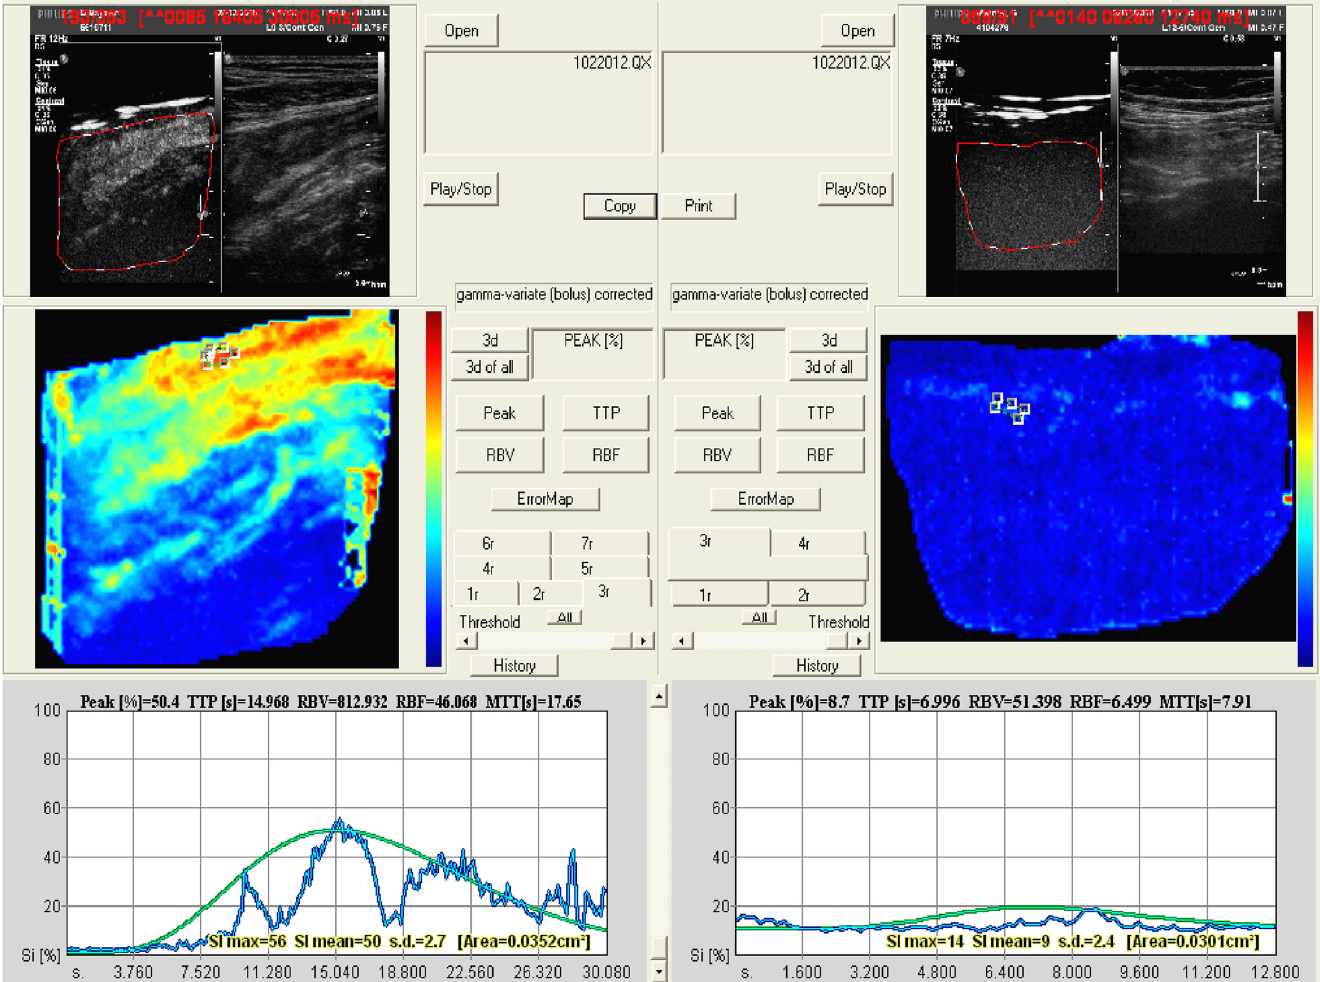
Fig 1. Perfusion map obtained by Qontrast software. Left side: contrast uptake based on increased microvascularization of the terminal ileum in a patient with severe endoscopic disease activity. Right side: contrast uptake of the terminal ileum in a patient with normal endoscopic appearance.